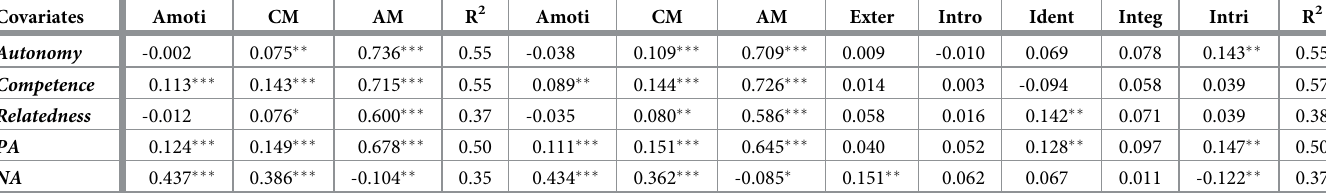
Table 7. Standardized coefficients and explained variances for types of motivation regressed on covariates. Covariates Amoti CM